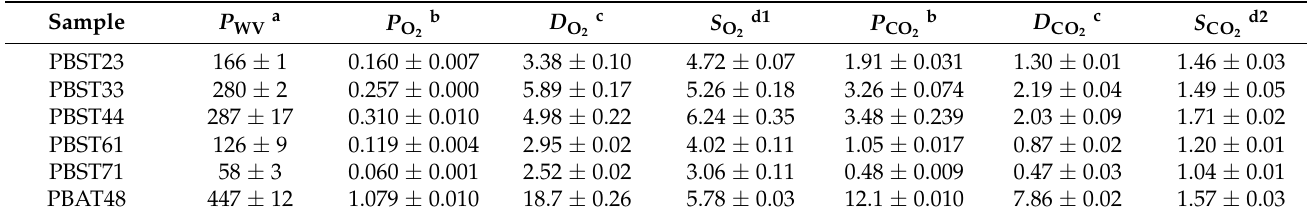
Table 3. Measured gas permeation coefficients ( P WV , P O S CO ) of PBST and PBAT48 copolyesters. 2